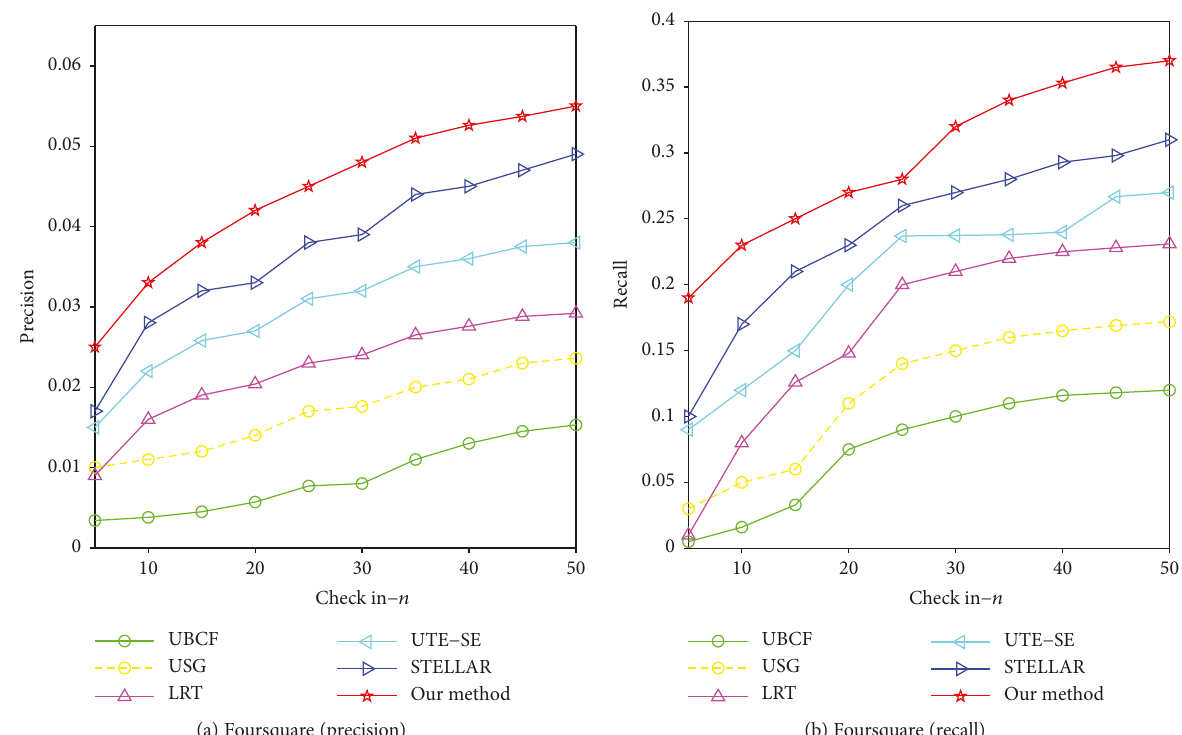
Figure 9: E ff ect of numbers of check-in locations of users on Foursquare